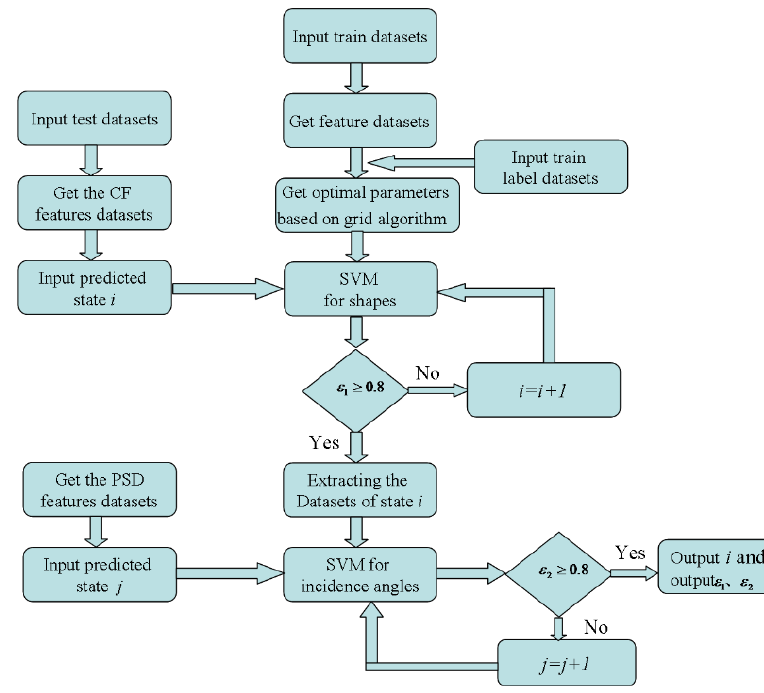
Figure 16. Workflow of the proposed classification strategy.